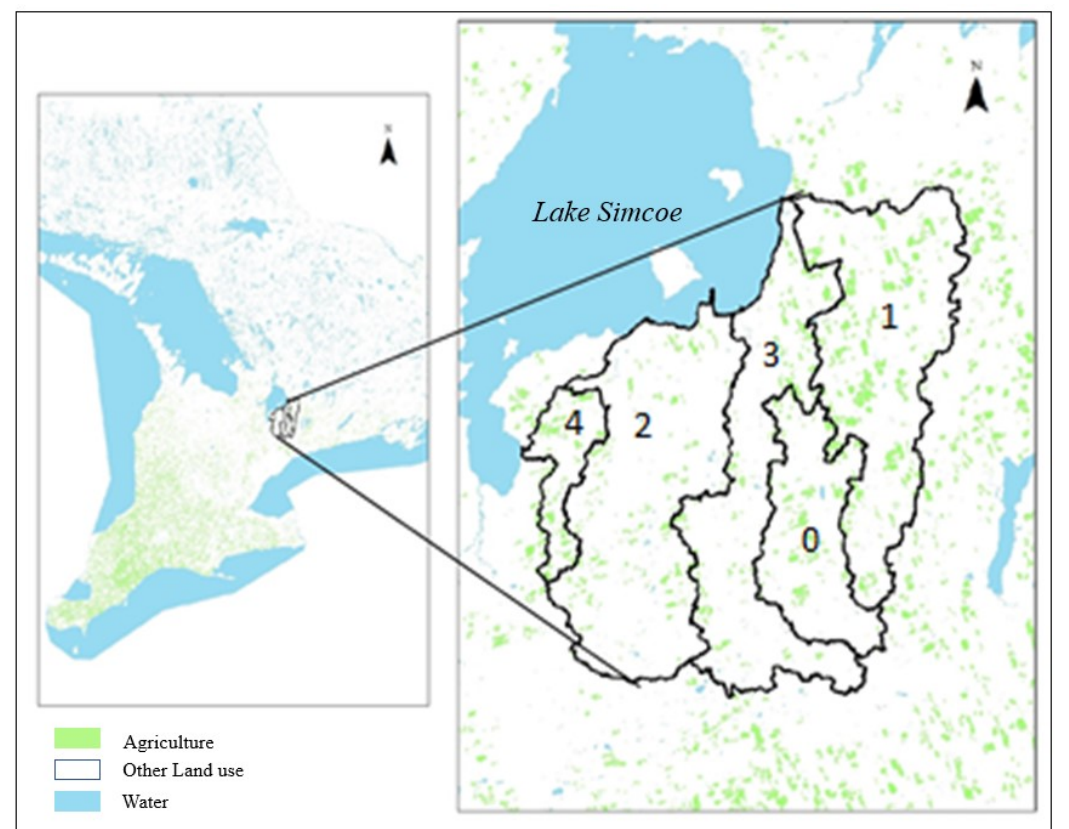
Figure 2. Agricultural areas shown in green across the Uxbridge Brooke (0), Beaver River (1), Maskinonge River (2), Pefferlaw River (3), and Black River (4) subwatersheds. Image manipulated from AAFC annual crop inventory [12].